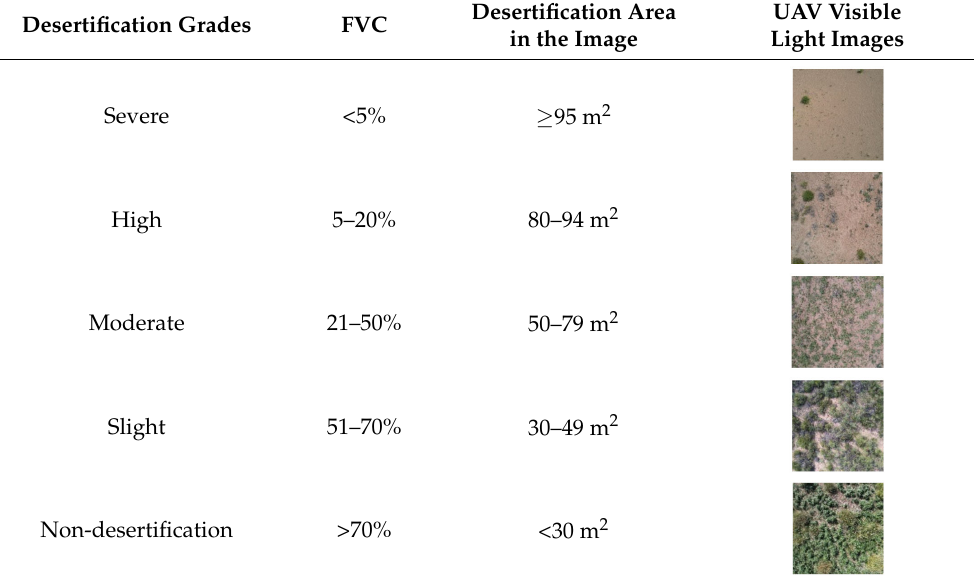
Table 1. Desertification